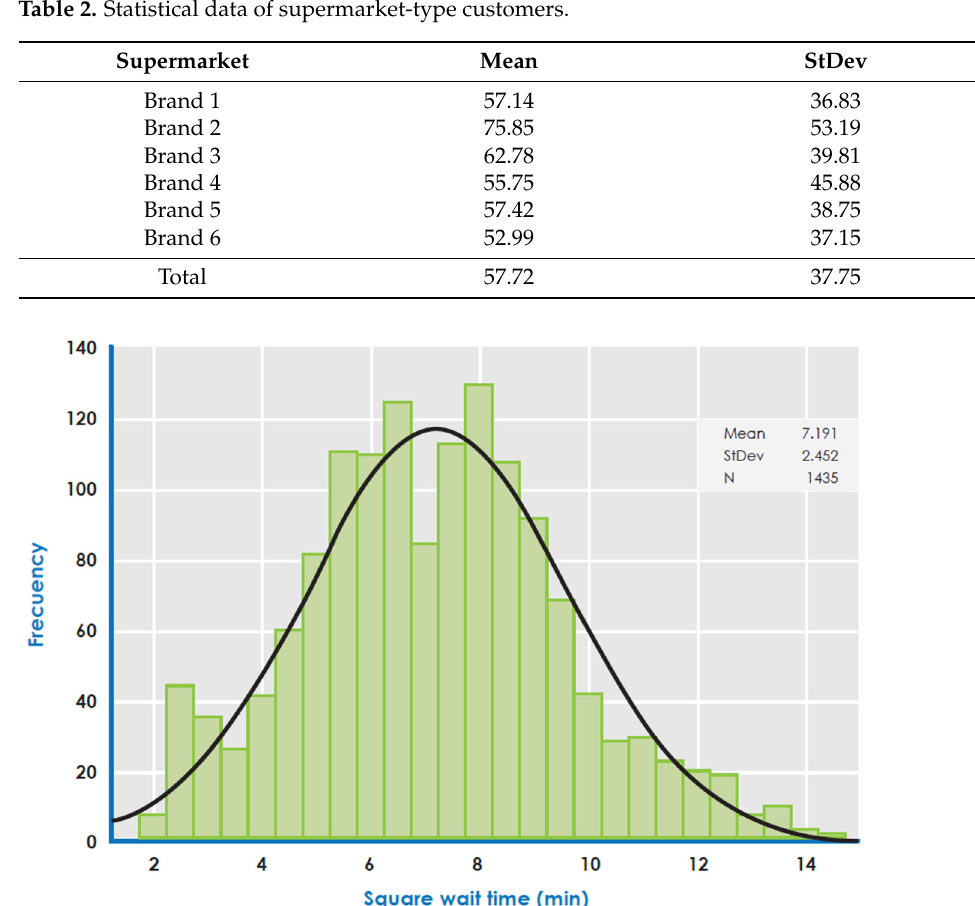
√ x to supermarket waiting